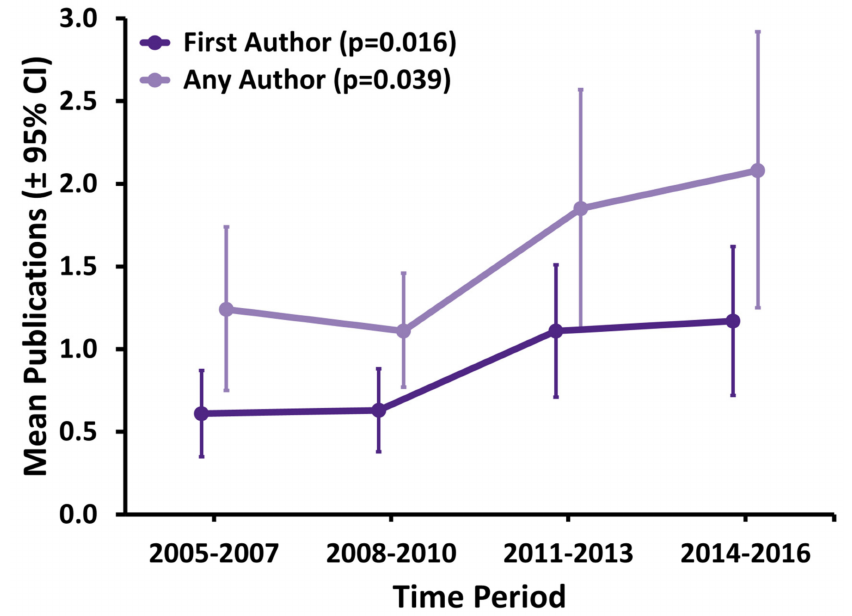
Figure 3. Summary of publication rates for first- and any-author publications by time period ( n = 227). p -values reported from linear trend test. Abbreviations: CI = confidence